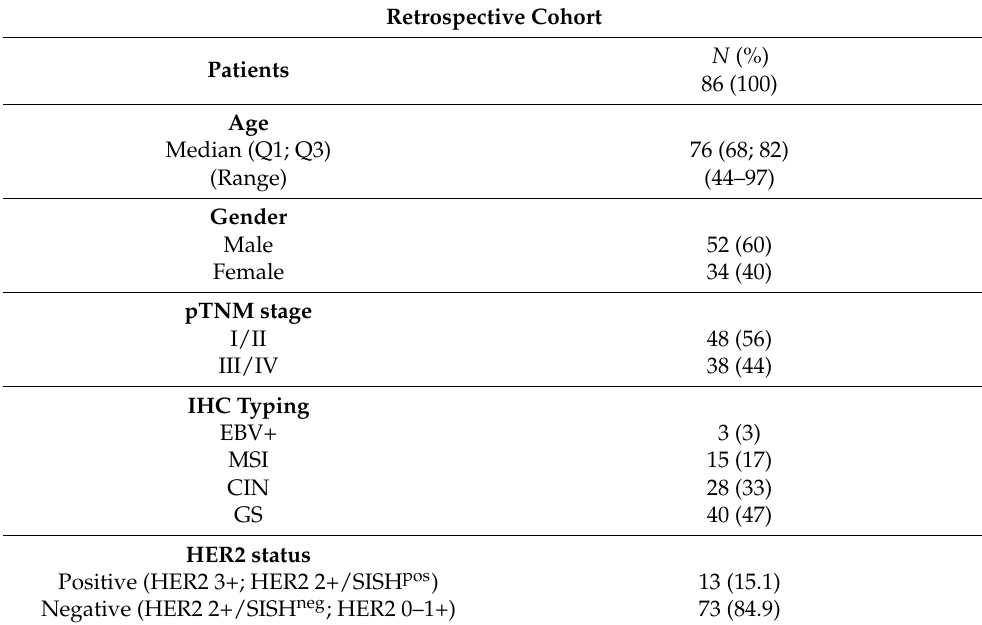
Table 1. Clinicopathologic characteristics of the retrospective cohort of gastroesophageal adenocarci- noma (GEA) patients.